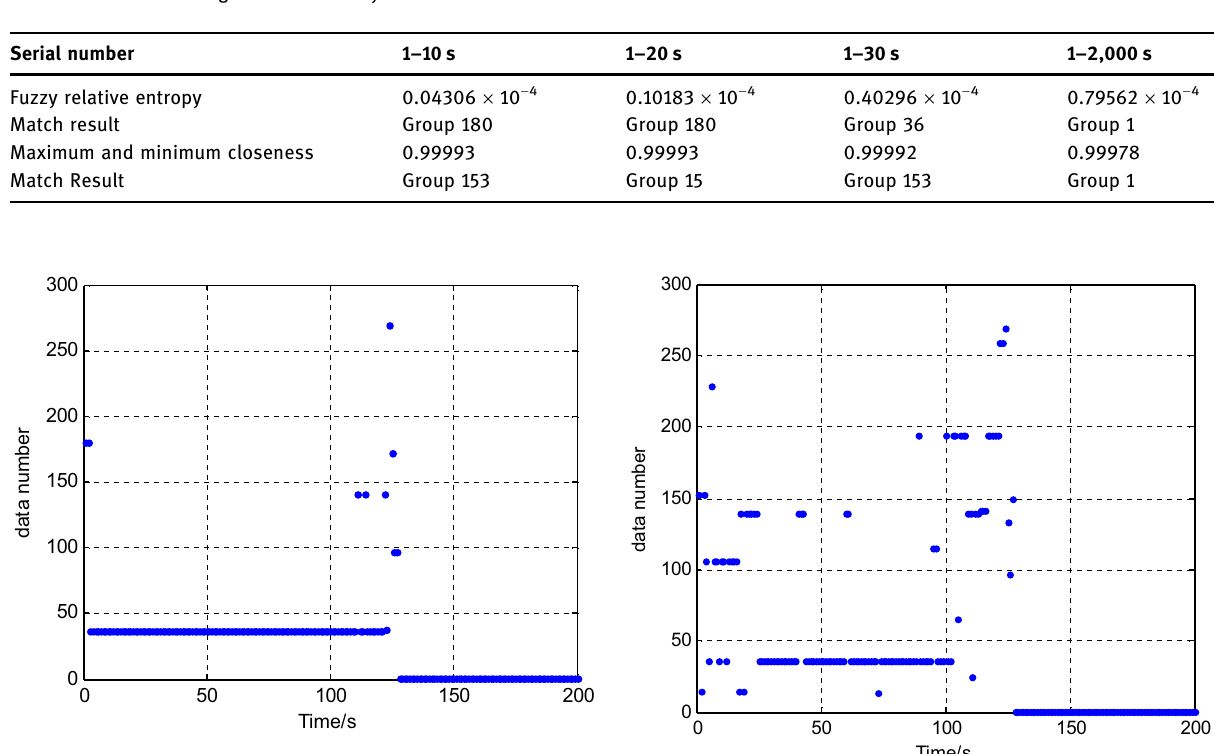
Table 4: Results of recognition once every 10 s